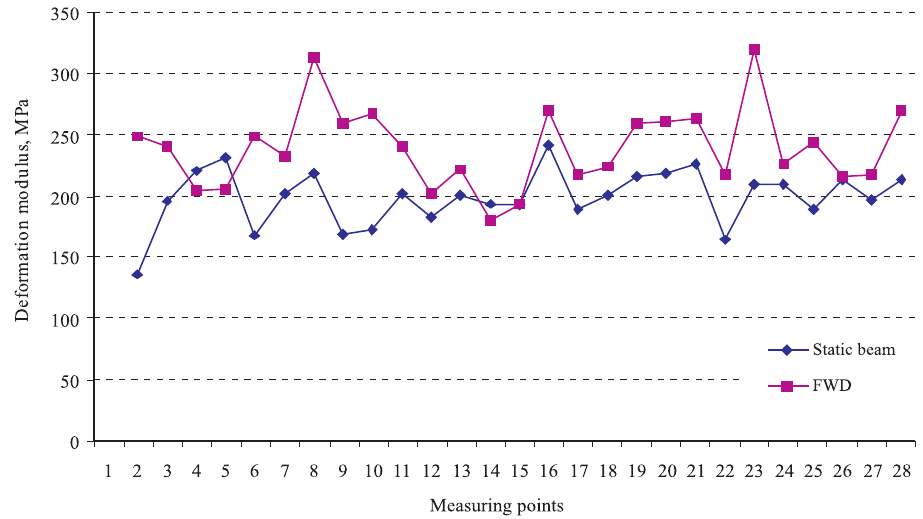
Fig. 2. Strength of a base course measured by all the above-mentioned devices (left